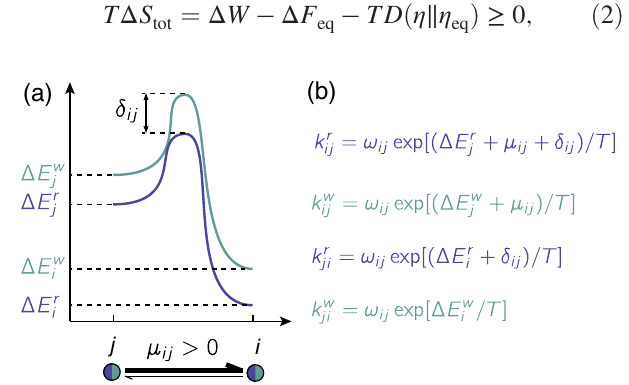
FIG. 3. Energy landscape and kinetic rates. (a) Energetic diagram of a single transition in the reaction network. (b) Cor- responding kinetic rates. The transition j → i can be driven by energy differences and the chemical driving μ ij . Transitions involving a right and a wrong monomer can be characterized by different kinetic barriers δ ij , as well as different energetic landscapes Δ E w j ≠ Δ E r j . The bare rate ω ij is the inverse character- istic time scale of each